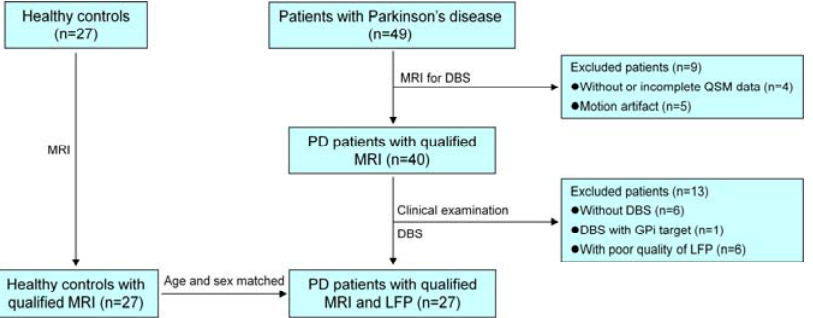
Figure 1. The screening process for including PD patients and healthy controls. MRI = magnetic resonance imaging, PD = Parkinson’s disease, DBS = deep brain stimulation, QSM = quantitative susceptibility mapping, GPi = globus pallidus interna, LFP = local field potential.